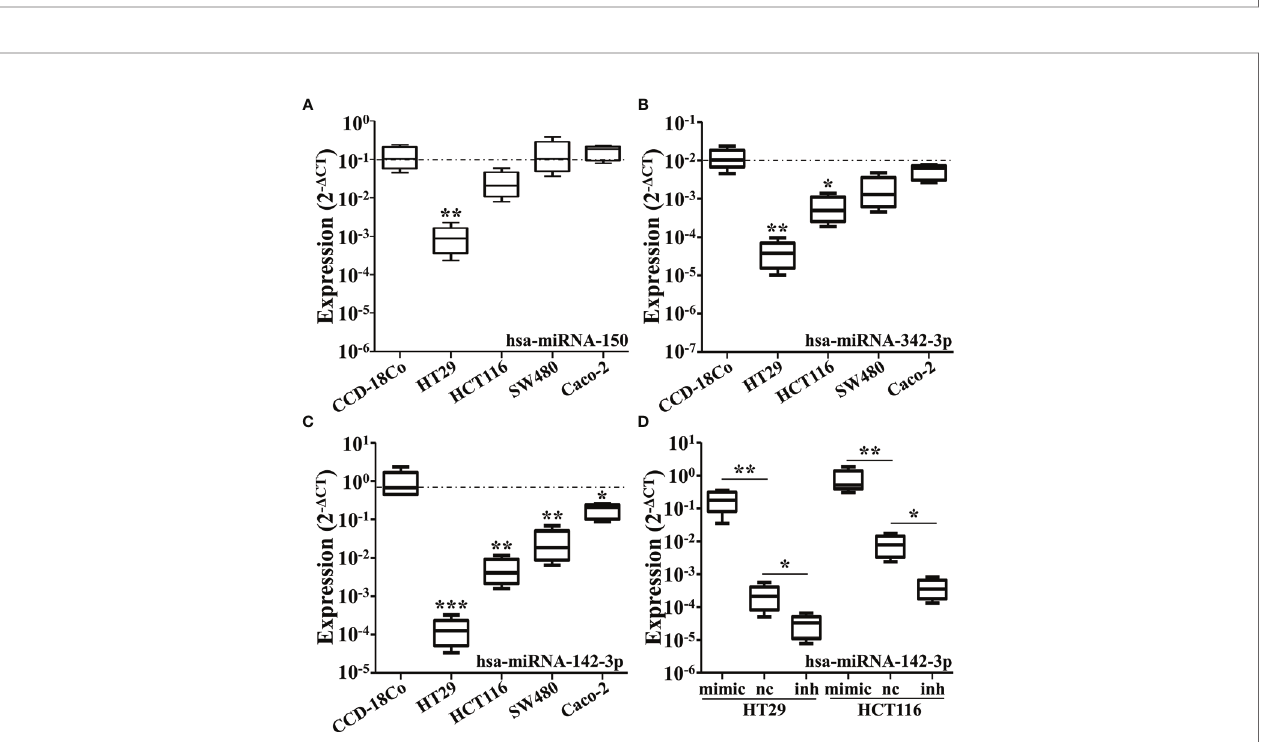
FIGURE 1 | Mi-142-3p is down-regulated in the plasma of patients with colorectal tumor. (A) Cluster analysis of miRNAs in the plasma of 10 CRC patients and 6 healthy controls. The expressions of down-regulated miRNAs, including miR-150 (B) , miR-342-3p (C) and miR-142-3p (D) in the plasma of CRC patients and healthy controls were detected by qRT-PCR. All data are shown as means ± SD. ***P<0.001.